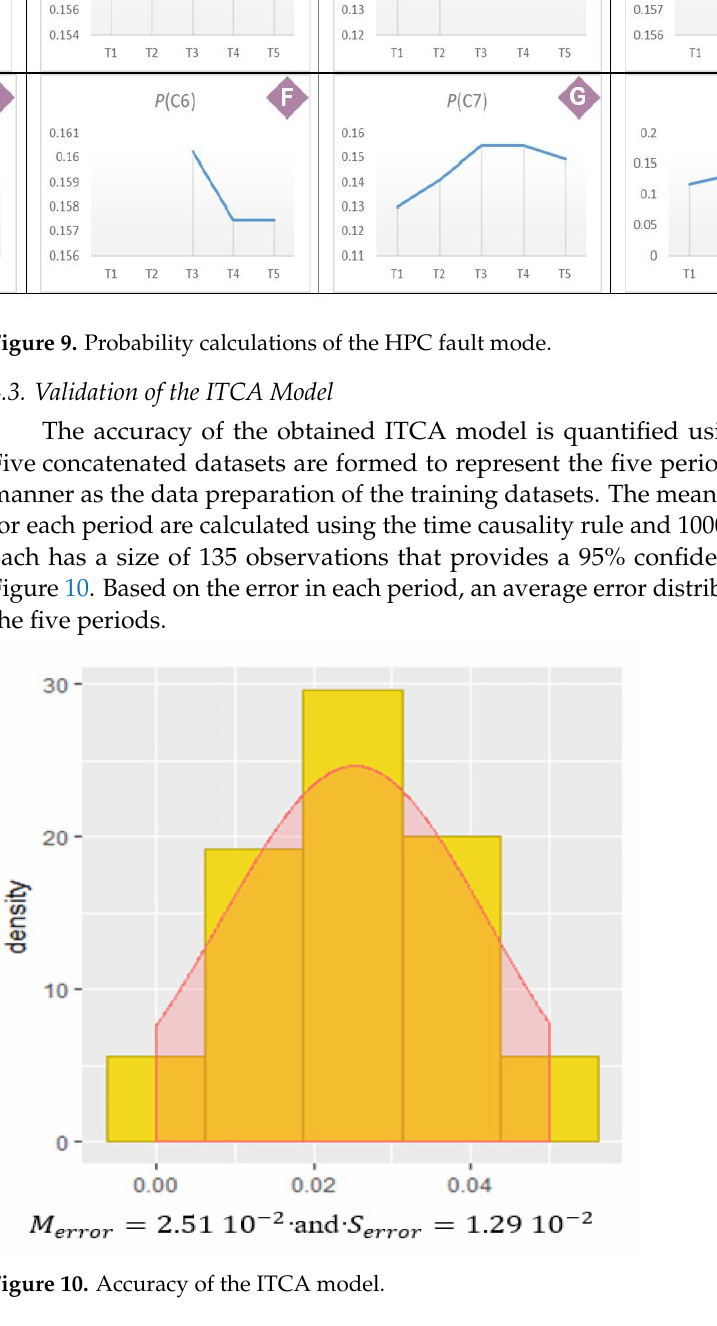
Figure 10. Accuracy of the ITCA model.